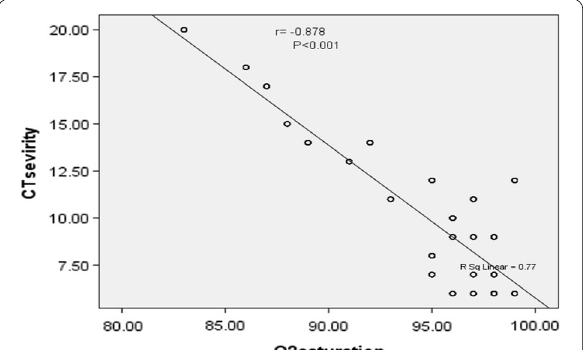
Fig. 6 Negative correlation between chest CT severity score and oxygen saturation level among studied